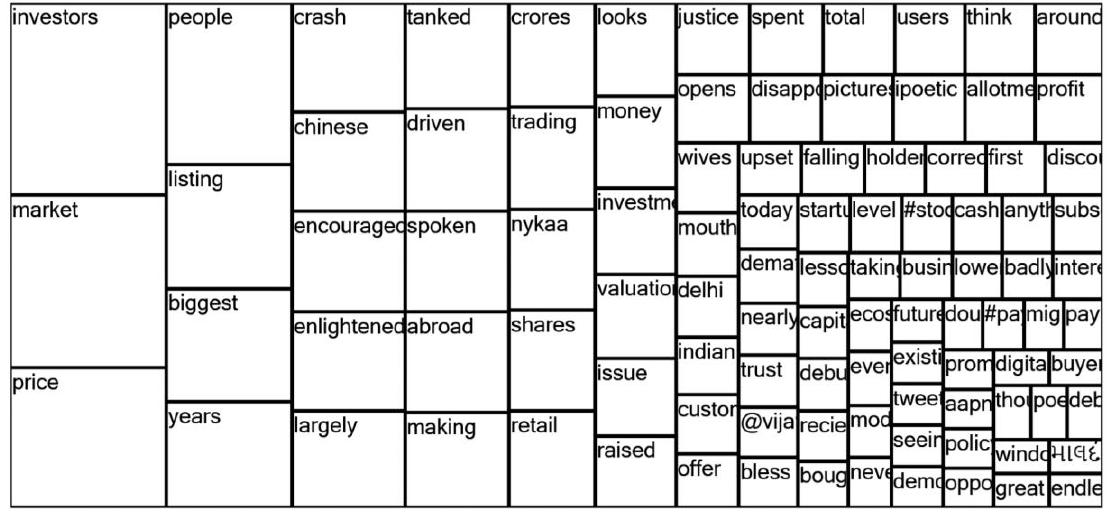
Figure 2. The Word Cloud expanded in tabular